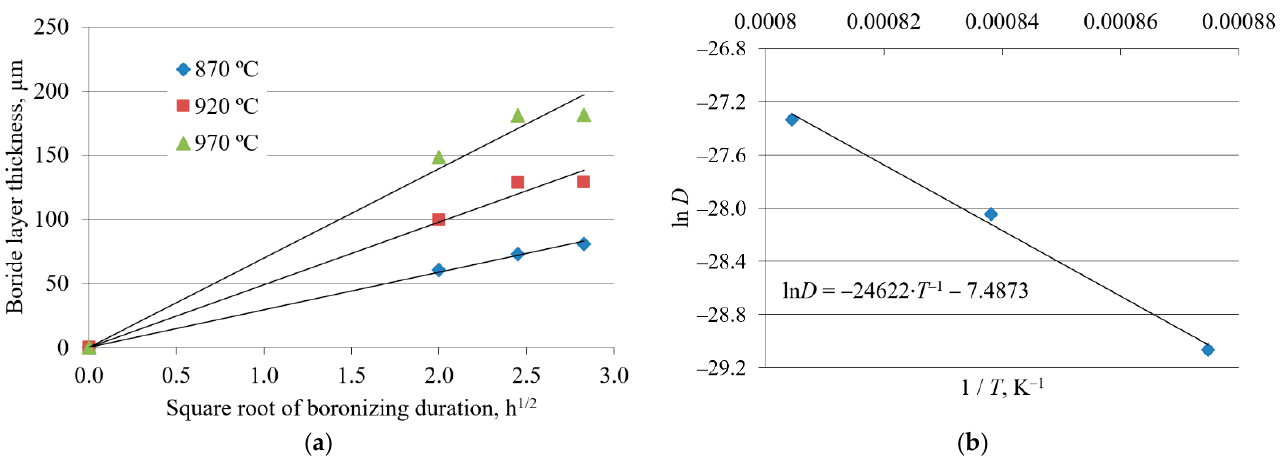
Figure 7. Growth kinetics of boride layers on C70W2 steel: ( a ) Boride layer thickness as a function of the square root of the boronizing duration; ( b ) natural logarithm of growth rate constant as a function of the reciprocal boronizing temperature [43]. Reprinted with permission from ref. [43].